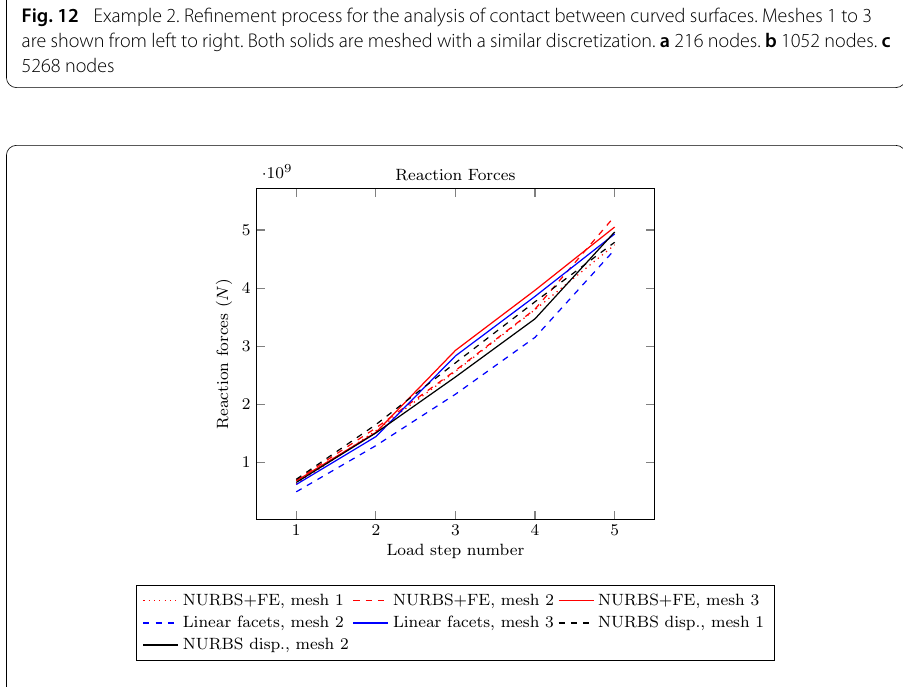
Fig. 13 Example 2. Reaction forces on the Dirichlet constrained surfaces during the load